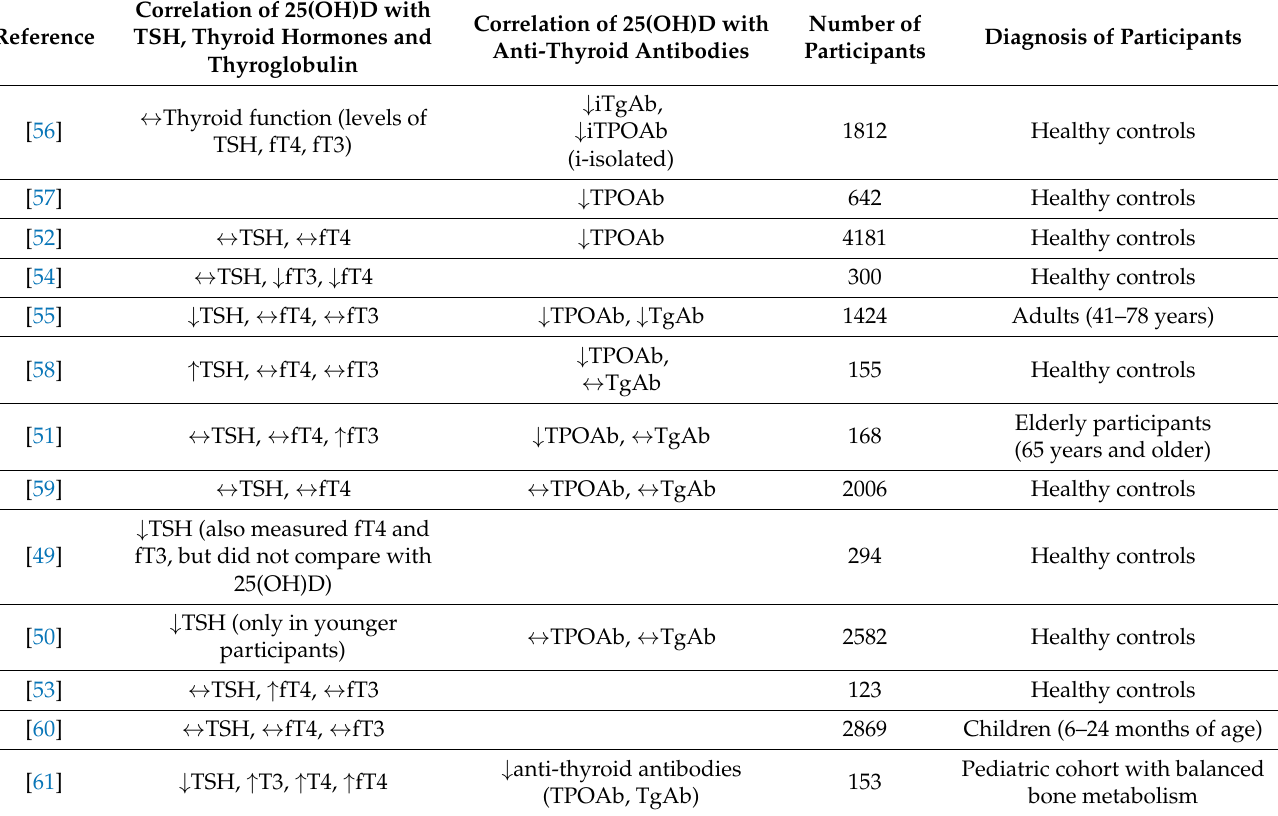
Table 1. Correlation of 25(OH)D with TSH, thyroid hormones, thyroglobulin and anti-thyroid